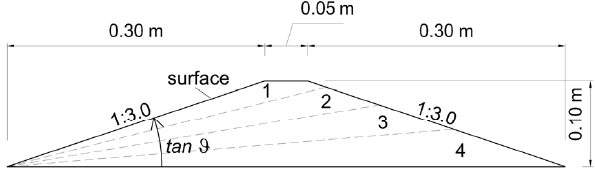
Fig. 5. Cross-section of the embankment with the hypothesis of five homogenous compactness zones (identified as surface, 1, 2 ... 4). The erosion, in time, affected layers with increasing compactness: at first, the upper layer (surface and nr. 1) and afterwards the lower layers (nr. 2–3). Flume water is on the right side of the section. Fig. 6 Downstream view of the embankment erosion. a) Stage 1: water reaches the embankment crest, particles are easily moved and a little debris flow originate; b) Stage 2: erosion of the slopes, started in small rills, continues within small channels progressively widening to the whole width. Increasing scour lead increasing water discharge, so debris flow evolves into immature debris flow; c) Stage 3: water sediment stream, occupying all the embankment width, is approximately mono-dimensional: during this phase a great amount of data were collected by pictures taken through the transparent wall of the canal. Immature debris flow evolved towards ordinary bed load; d) Stage 4: when the structure was completely removed, the water discharge began to decrease and the flume emptied.